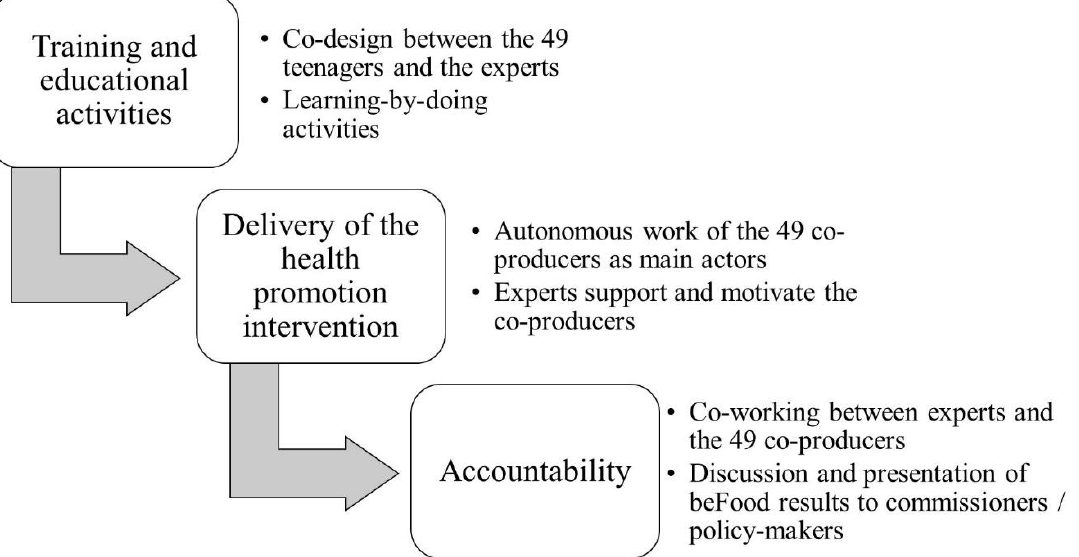
Figure 1. Phases of the beFood project.